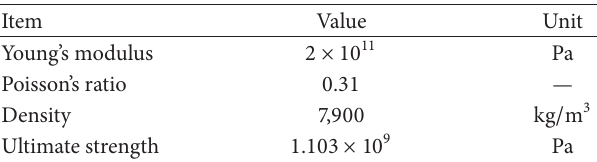
Table 1: The material properties used in constructing of the members of the model.